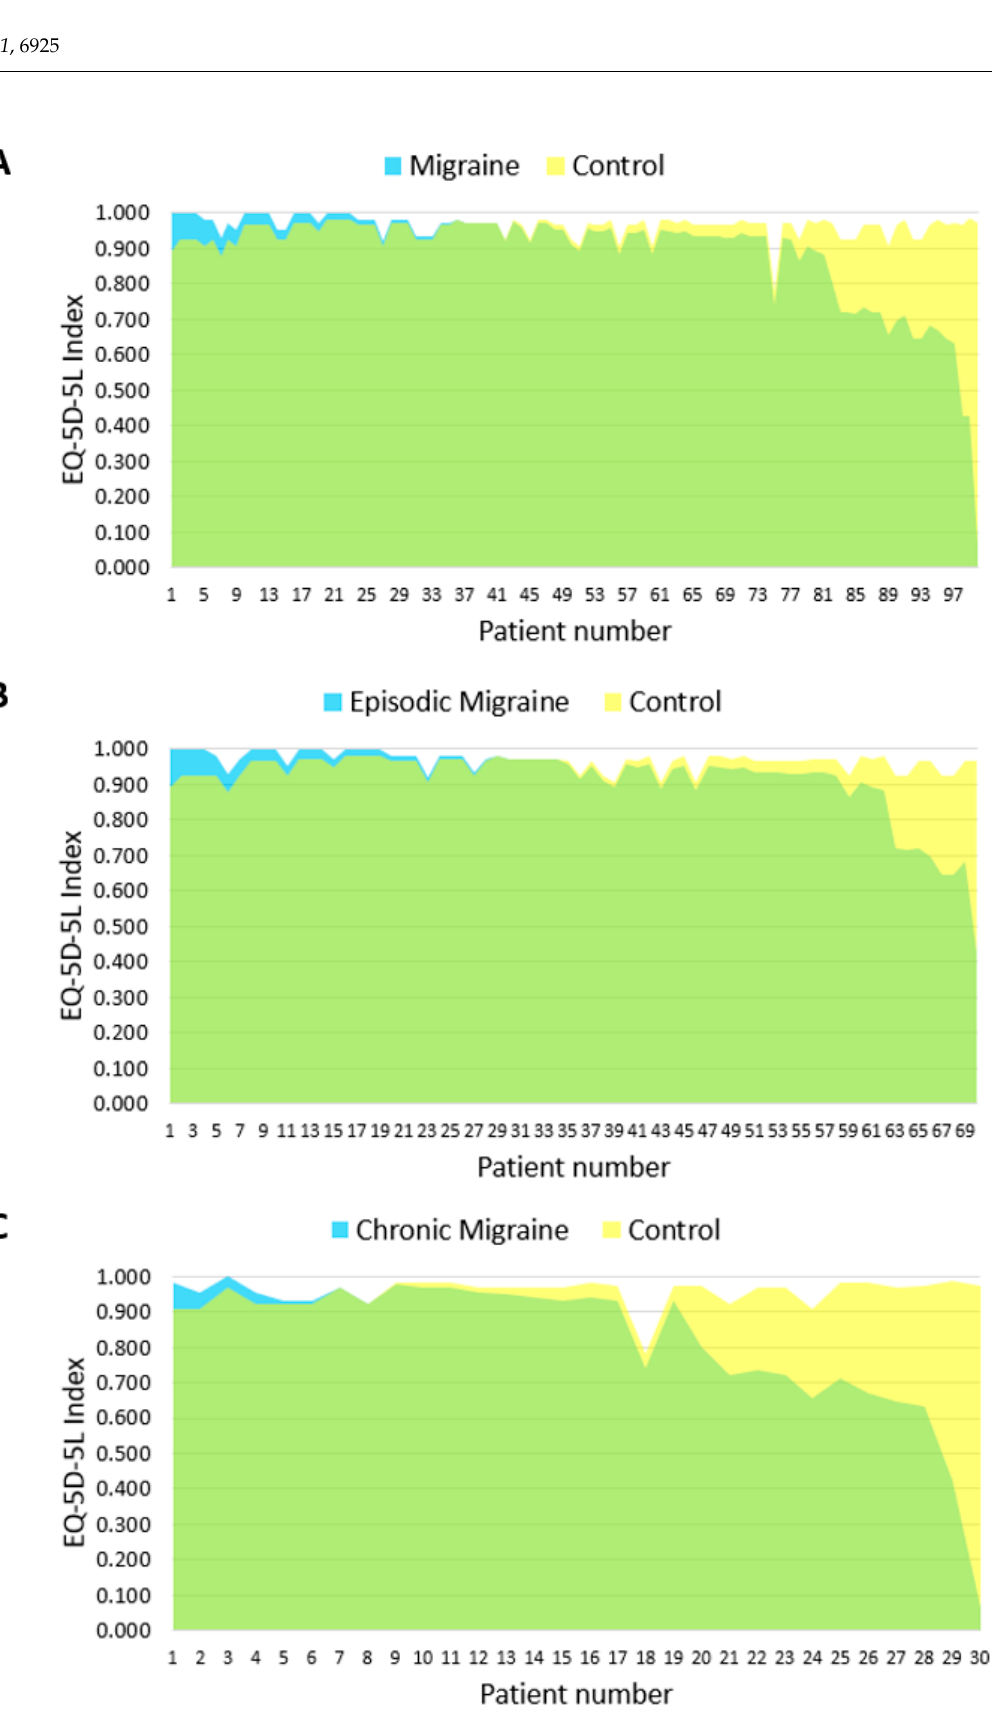
Figure 2. The burden of ( A ) migraine, ( B ) episodic migraine and ( C ) chronic migraine according to the EQ-5D-5L Index. Yellow color denotes health utility lost due to the disease in comparison to controls from the general population.